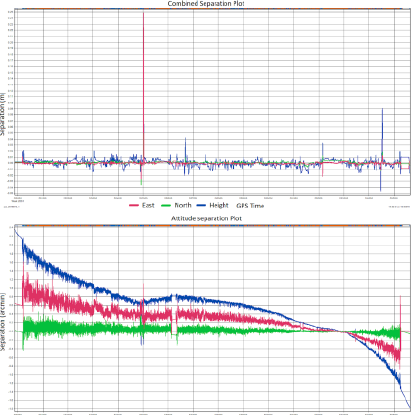
Figure 4. Combined separation and attitude separation plot for the thaw slump trajectory. The time is shown on the x axis, y plots the separation in meters (top) and in arcmin (below).